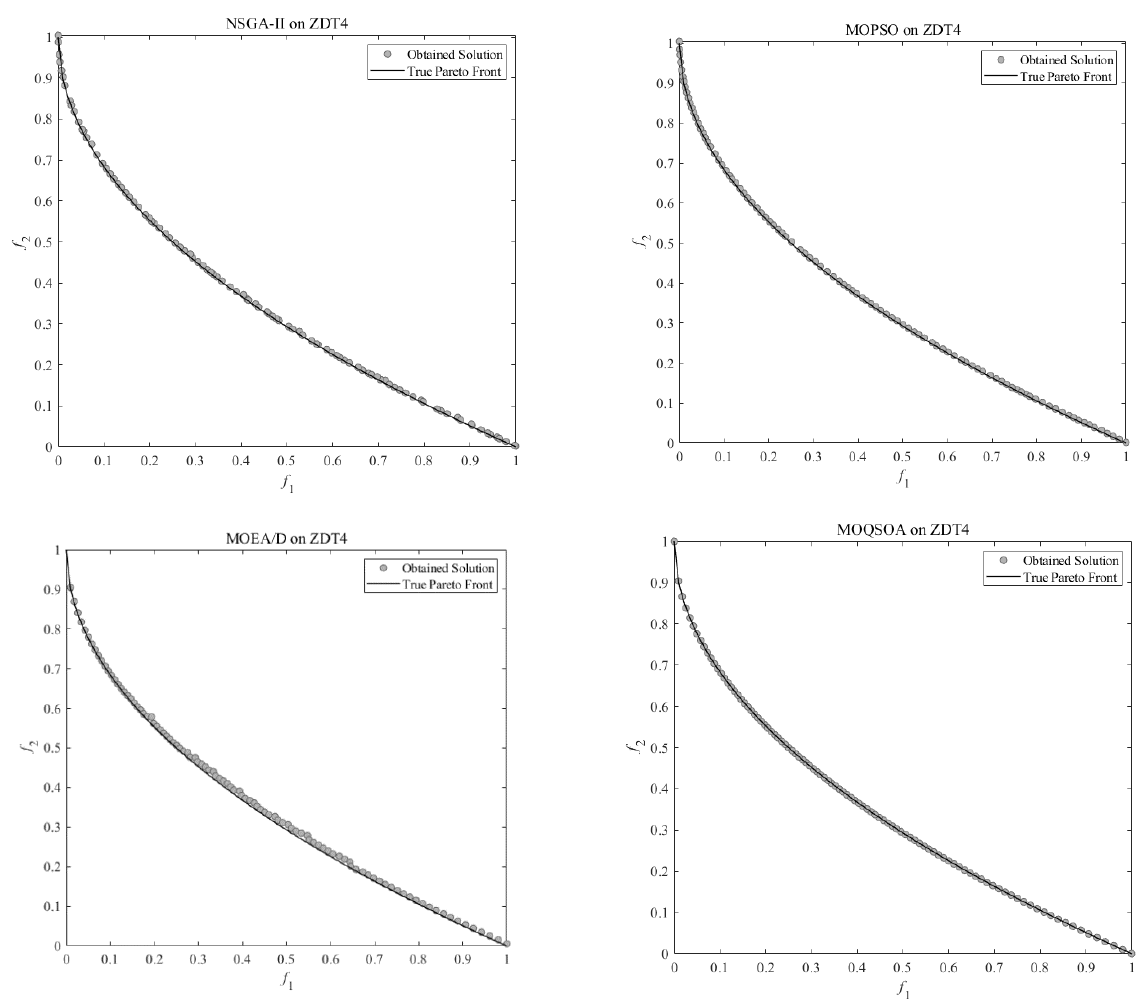
Figure 4. Pareto fronts of each algorithm for ZDT4.